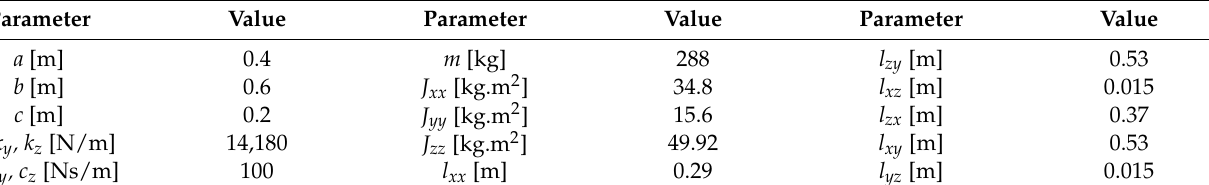
Table 1. Specifications of the controlled